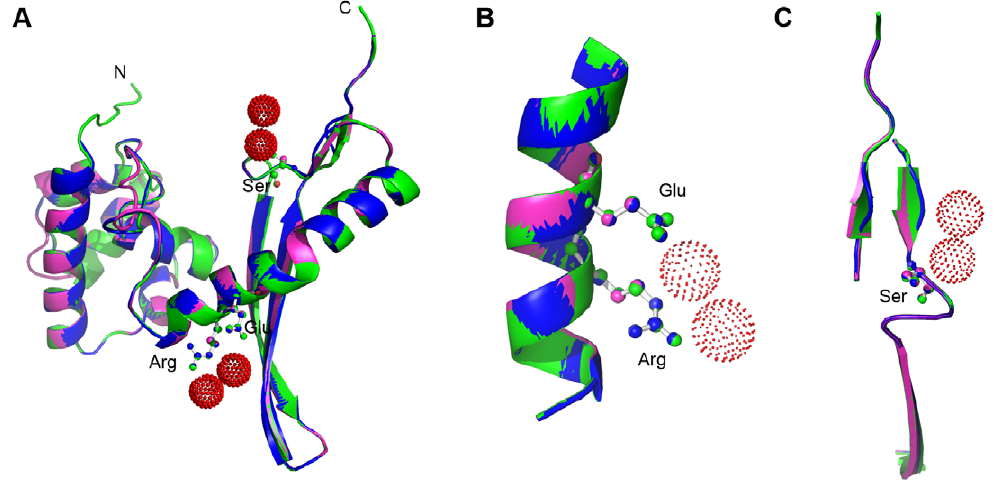
Figure 6. Homology modelling of AtCYN and OsCYN. (A) The predicted structures of AtCYN (blue) and OsCYN (magentas) were similar to the crystal structure of the EcCYN monomer (green). Ball-and-stick figures represent the conserved catalytic residues Arg96, Glu99 (B) and Ser122 of the EcCYN (C). Red dots indicate chloride ions.